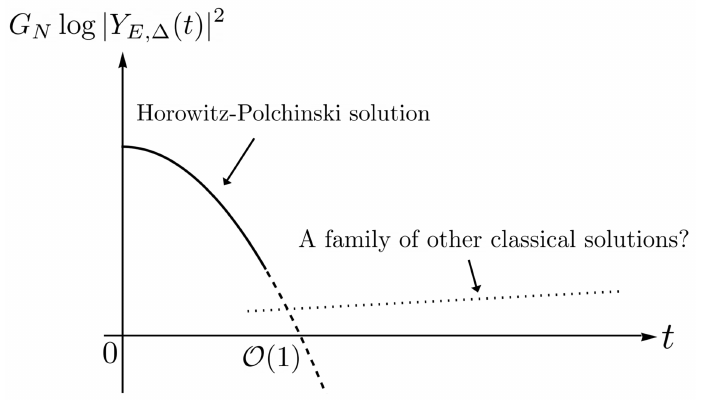
Figure 13 . The Horowitz-Polchinski solution leads to a decaying contribution for the spectral form factor. The free string discussion suggests that there can be a family of similar classical solutions which are responsible for the rise of the spectral form